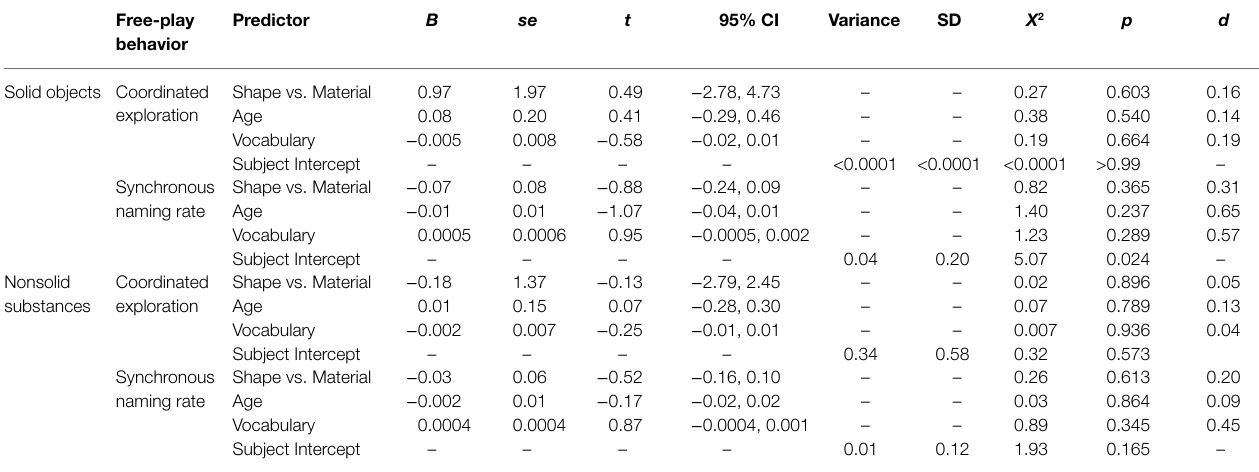
TABLE 3 | Results from mixed effects regression analyses comparing differences in free-play behavior related to generalization (shape vs. material). Free-play Predictor B se behavior Solid objects Coordinated